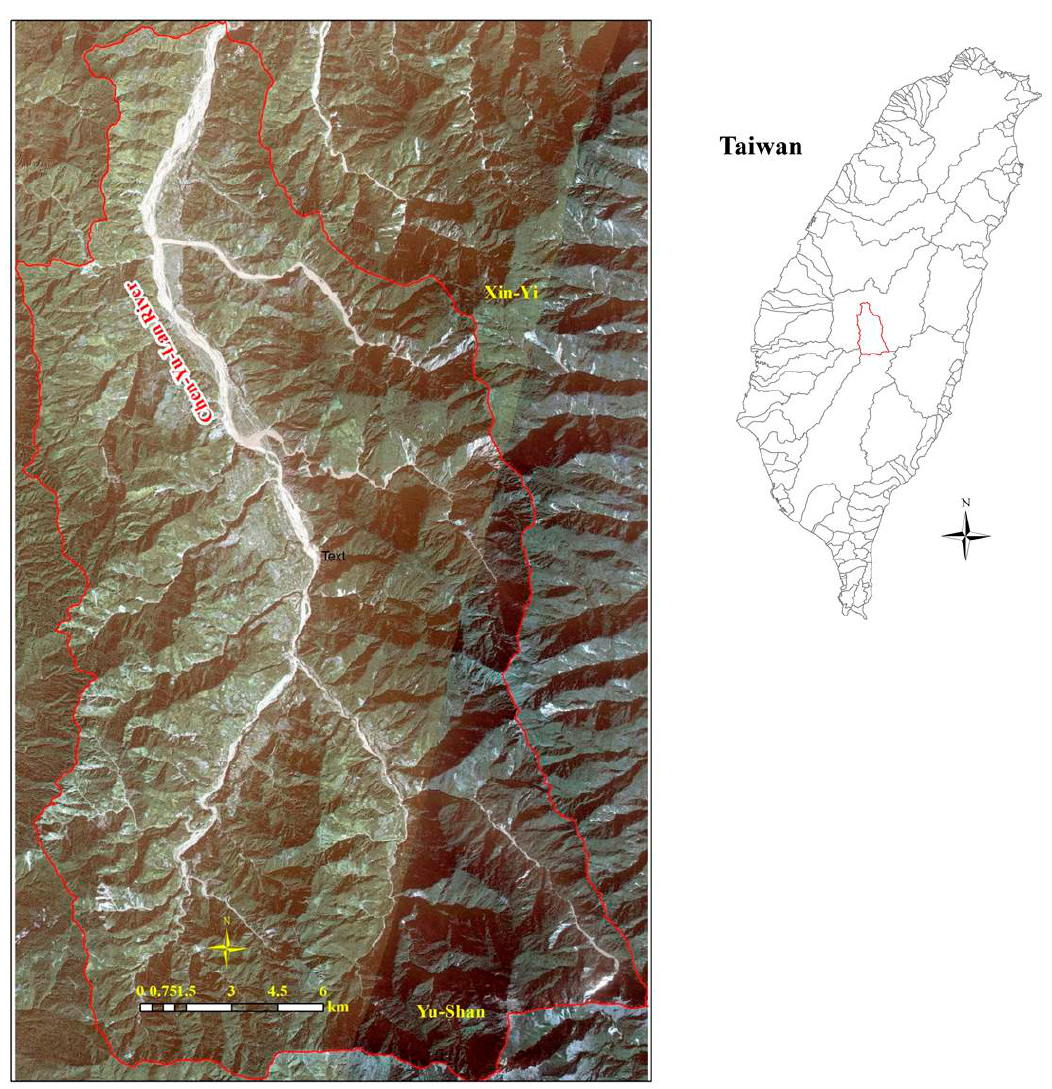
Figure 1. The study area.